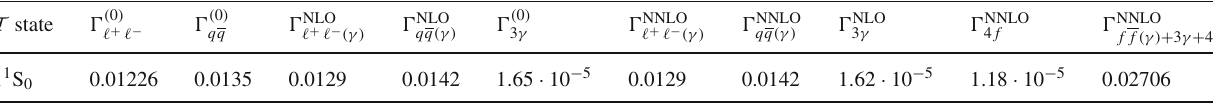
Table 6 Numerical values of the partial ortho-ditauonium decay widths (in eV) grouped by individual LO, NLO, and NNLO contributions to its total width. The last column gives the total NNLO (cid:19) ortho-ditauonium annihilation width. For the (cid:3) + (cid:3) − (γ) partial widths, dielectron and dimuon channels are added